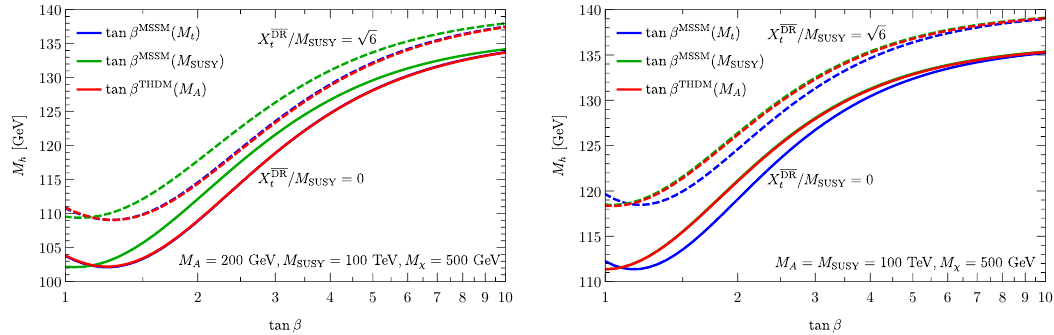
p =M SUSY = 0 (solid) and X DR =M SUSY = 6 t t